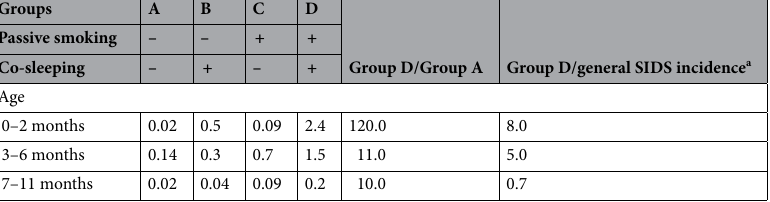
Table 6. Comparison of annual SIDS incidence rates per 1000 live births estimated with a Bayesian onset- predictive support model, with and without passive smoking or co-sleeping by age. a The incidence was calculated from the total SUID incidence rate (0.49/1000 births/year) in Japan and 64% of SIDS proportion in 64 SUID cases in this study, which is 0.3/1000 births. SIDS, sudden infant death syndrome; SUID, sudden unexpected infant